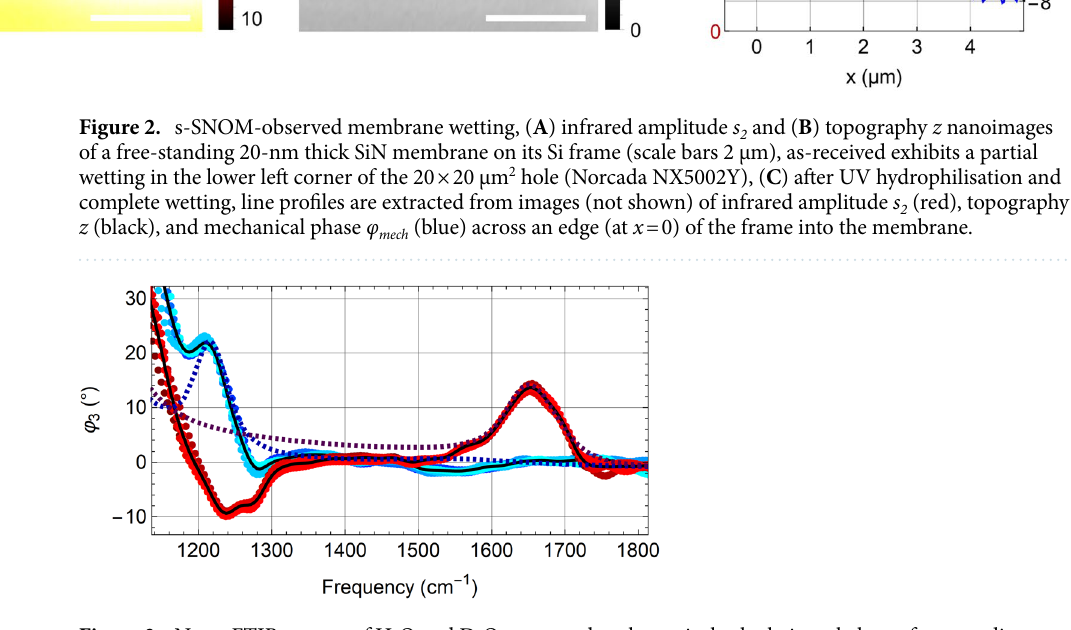
Figure 3. Nano-FTIR spectra of H 2 O and D 2 O compared to theoretical calculations, below a free-standing, 15-nm SiN membrane stretched over a 20 × 20 µm 2 hole (Norcada NBPX5002YZ-HR), of infrared phase φ 3 (round data points with black average curves) exhibiting the bending-vibrational resonances of H 2 O (red) or D 2 O (blue), at nominally 1644 and 1209 cm −1 , respectively 61 (see Supplementary Fig. S2 for simultaneously measured amplitude spectra, and for an H 2 O/D 2 O mixture). The theoretically predicted curves (square dots) for H 2 O and D 2 O under 15-nm SiN are calculated using the finite-dipole model of tip-confined near-field interaction extended to multi-layer objects (“Methods”), assuming a 100 nm tip radius and 70 nm tapping amplitude, plotted after multiplication by